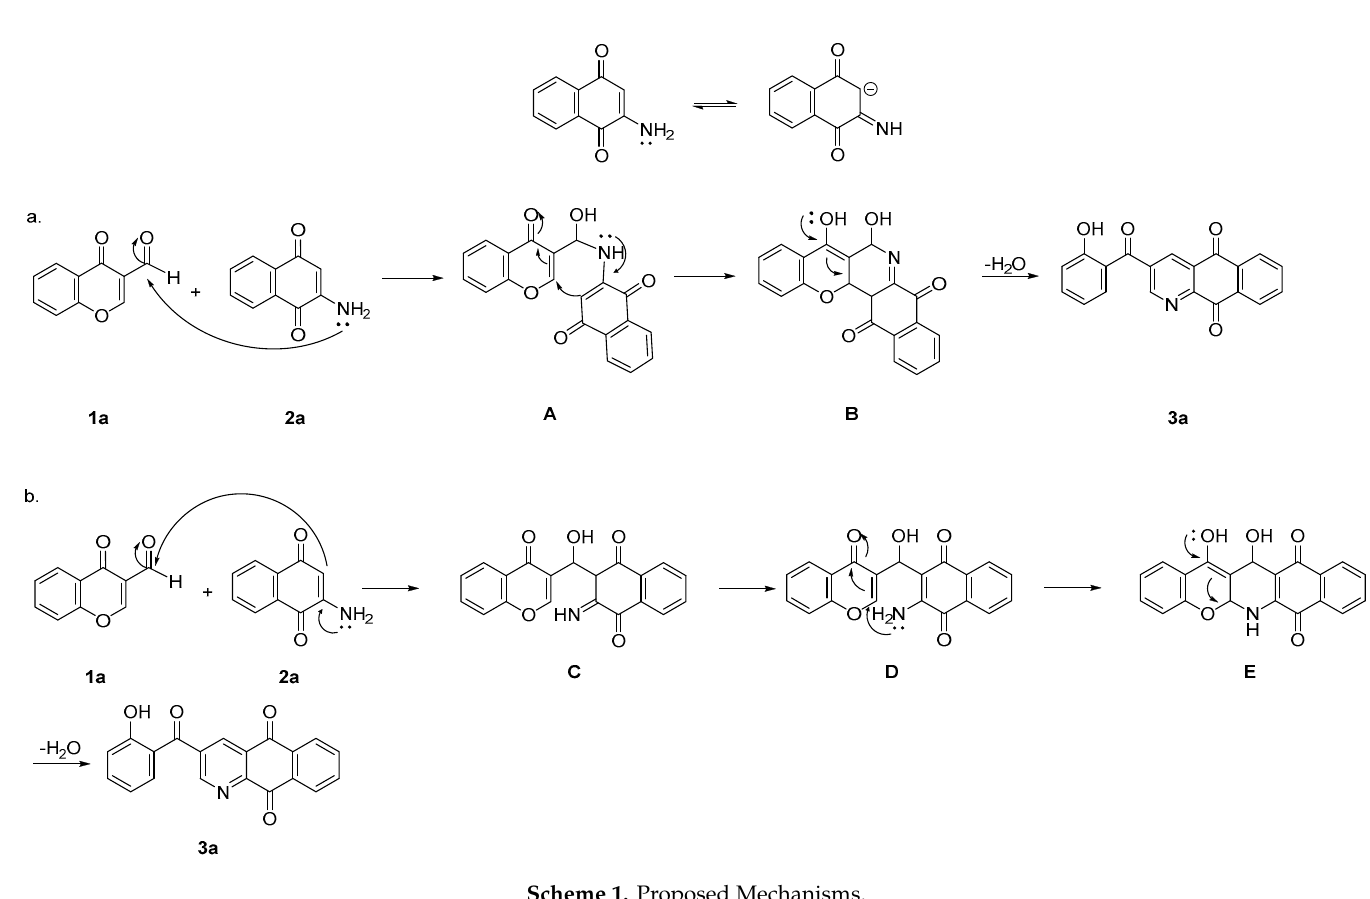
Scheme 1. Proposed Scheme 1. Proposed Mechanisms.